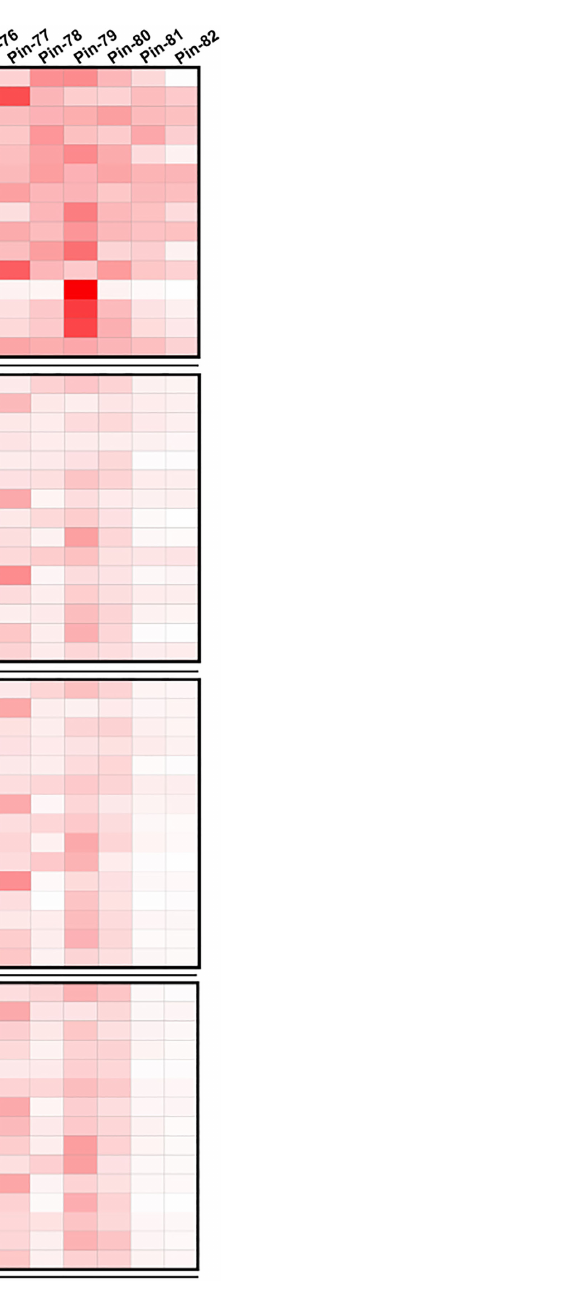
FIGURE 8 Pattern of antibody reactivity to p67C overlapping peptides in animals under challenge experiment. Pattern of IgG reactivity to overlapping 15- mer p67C peptides (named pins, as previously described in (40)), at day 28, 42, 56 and 77 after fi rst dose of